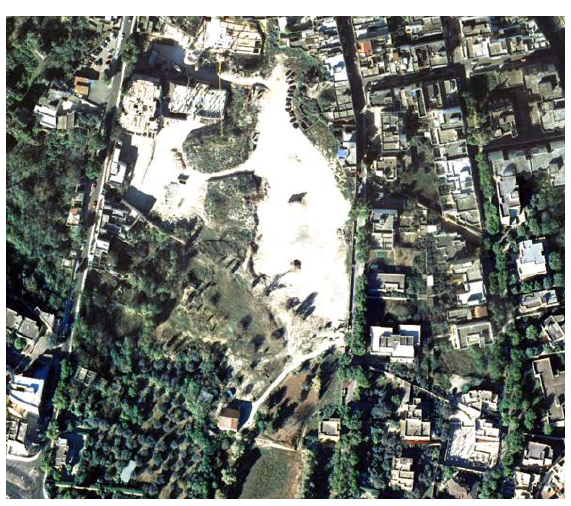
Figure 3. Quarry area before the